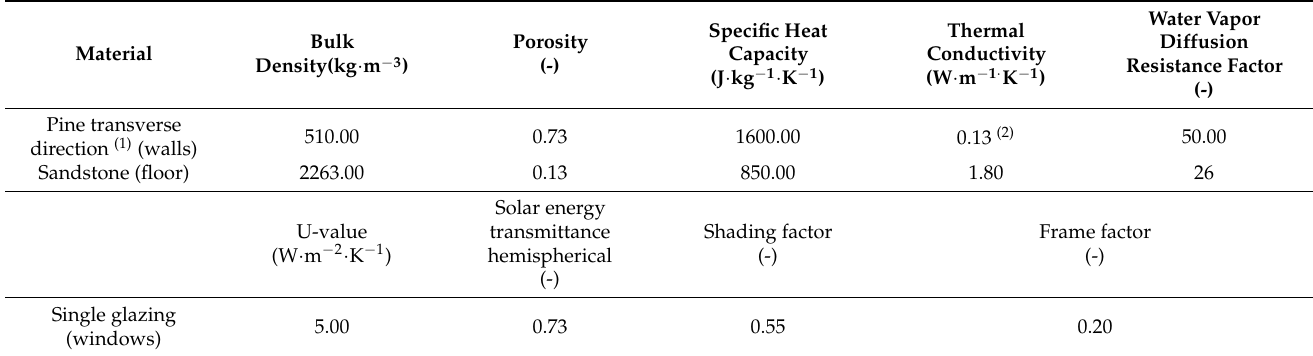
Table 1. Simulated building materials and technical parameters.